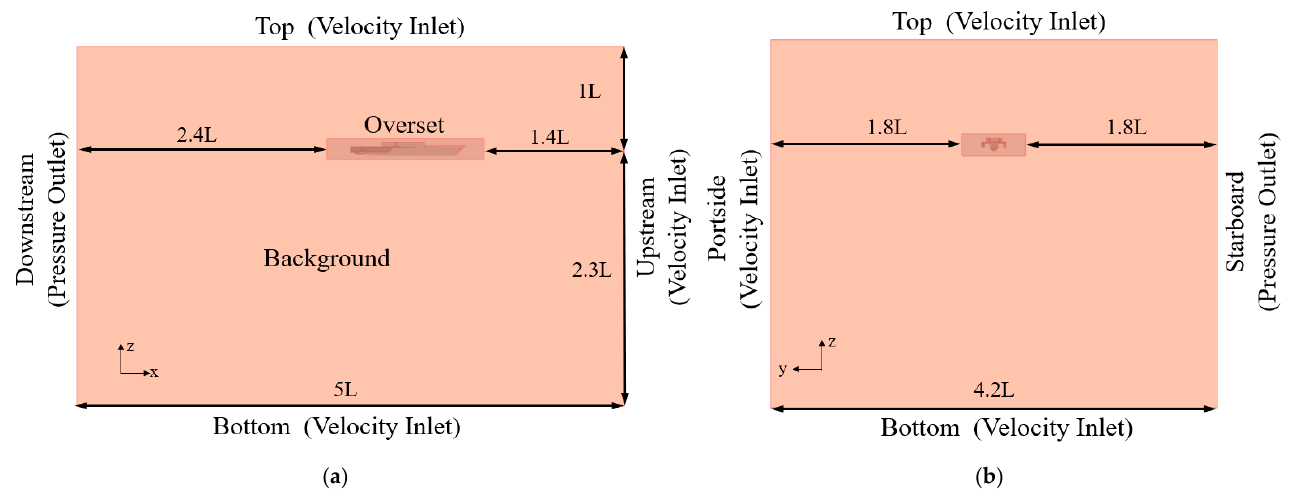
Figure 4. Computational domain and boundary conditions. ( a ) Side view; ( b ) Front view.